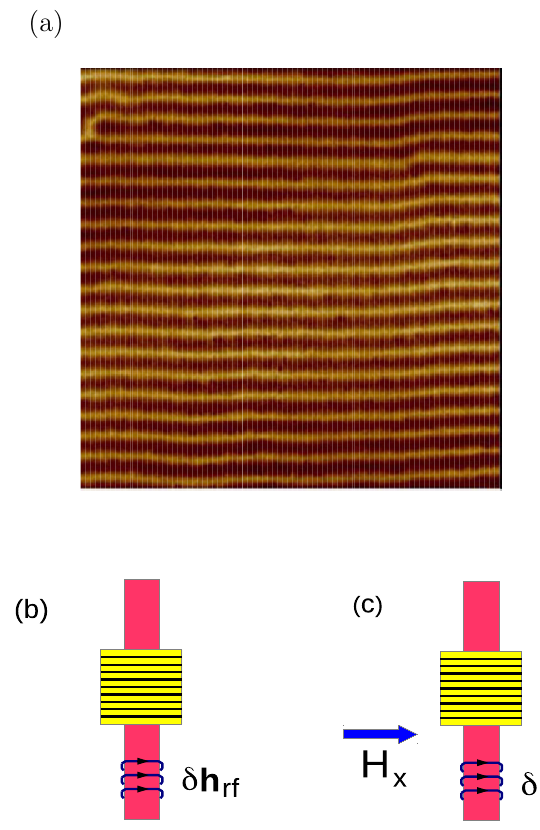
Figure 1. (a) Zero-field magnetic force microscopy (MFM) im- age of the parallel stripe domains for the studied garnet film with perpendicular anisotropy. The image size is 30 µ m × 30 µ m. Sketch of the experimental pumping field configurations without (b) and with (c) a DC magnetic field applied along the stripe do- main direction (x-axis). The in-plane component of the exciting magnetic field δ h rf is parallel to the stripe domain